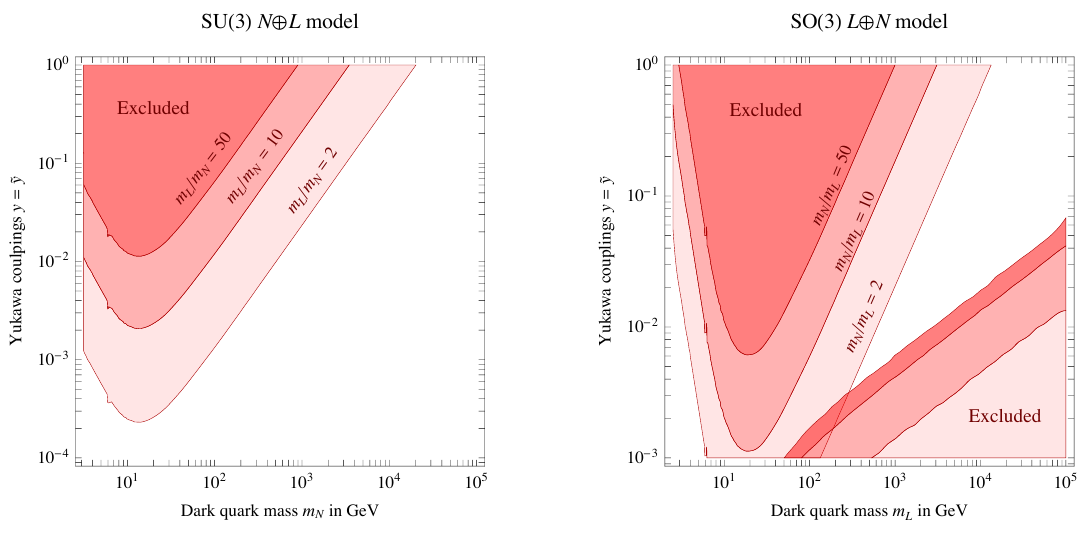
Figure 12 . Direct detection bounds, assuming dark quarks to the Higgs. Left: we consider the SU(3) model with m N < m L . Right: we consider the SO(3) model with m L < m N , such that a large enough Yukawa coupling is needed in order to suppress Z -mediated inelastic